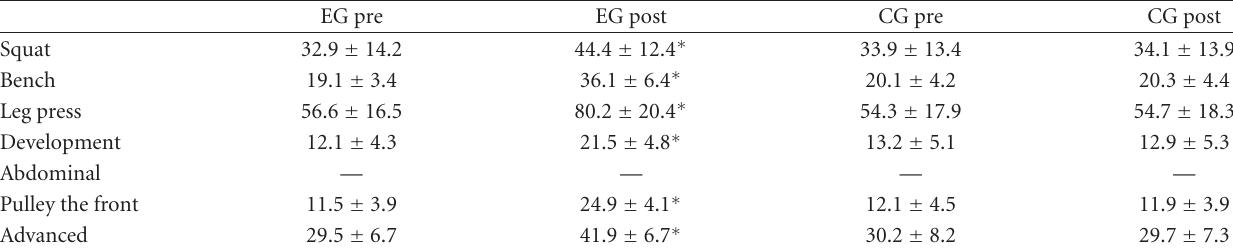
Table 1: Maximum load (1RM) in kilograms (kg) in the pre-and posttest (mean ± deviation).